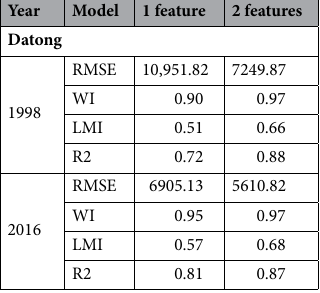
Table 6. Comparison of criteria with different features in Datong